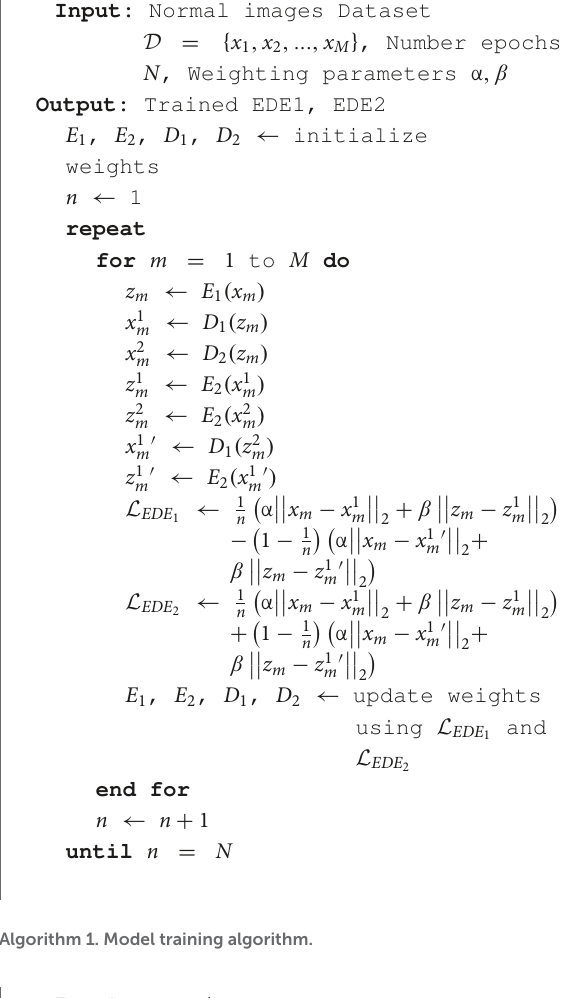
Algorithm 1. Model training algorithm.